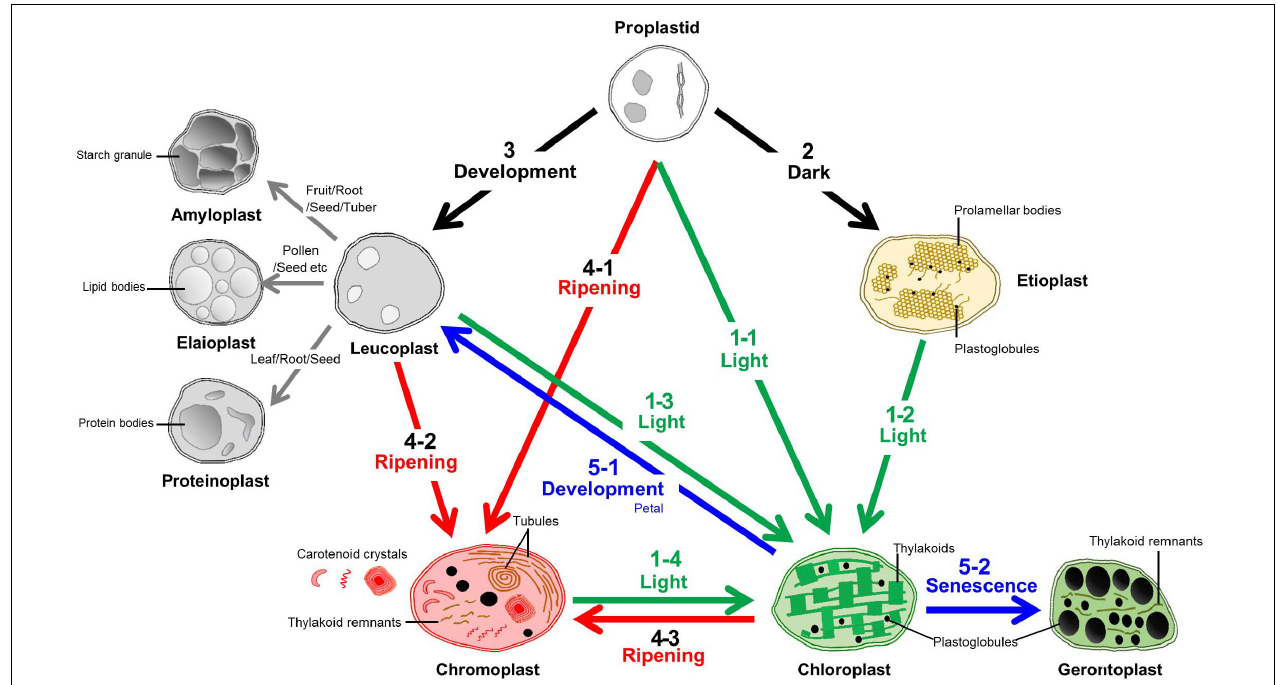
FIGURE 1 | Transition pathways among various plastids. The characteristics and plastid interconversion pathways of the plastids were classified according the color and number of the arrow. The transition to a chloroplast is called “Greening” and identified with the number “1”. This is mainly triggered by light signals from proplastids, etioplasts, leucoplasts, and chromoplasts. Etioplasts can develop from proplastids in dark conditions and this identified by the number “2”. The number “3” indicates leucoplast development that is triggered by diverse development processes to generate starch, lipid, and protein enriched sub-types called amyloplasts, elaioplasts, and proteinoplasts, respectively. Mainly during the ripening stage, diverse types of the carotenoid crystals were generated within the plastids called chromoplasts from the proplastids, leucoplasts, and chloroplasts and this is identified with the number “4”. Together with etioplast and leucoplast development (2,3), chromoplast development (4) was identified as a “Non-greening” plastid transition. The loss of green color from the chloroplasts is called “De-greening” and identified with the number “5”, and these chloroplasts are then transited into leucoplast or gerontoplast by developmental regulation or during senescence,